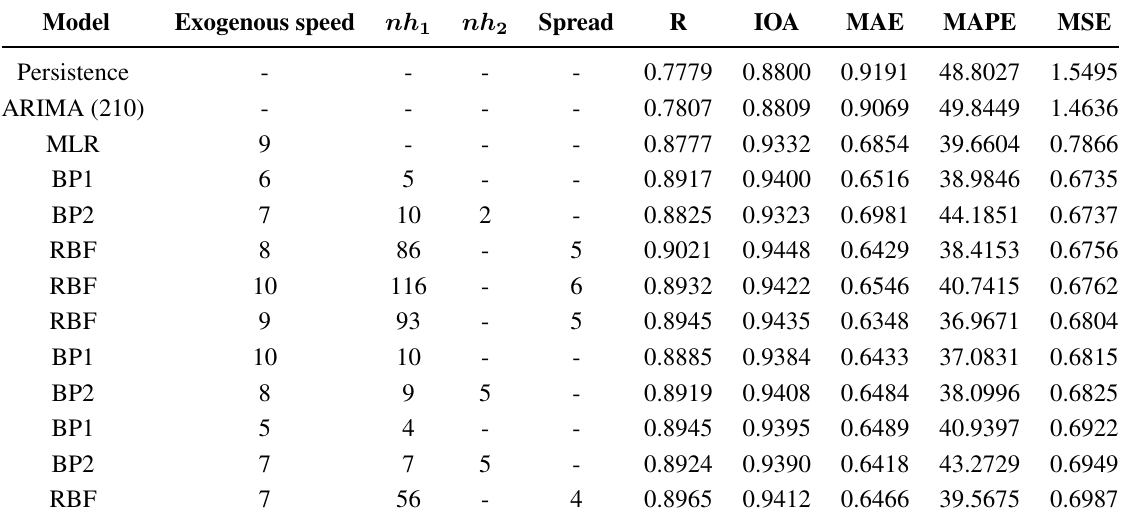
Table 7. Parameters and results achieved on the test set by the reference models vs. the ten best models. IOA: index of agreement; MAE: mean absolute error; MAPE: mean absolute percentage error; and MSE: mean squared